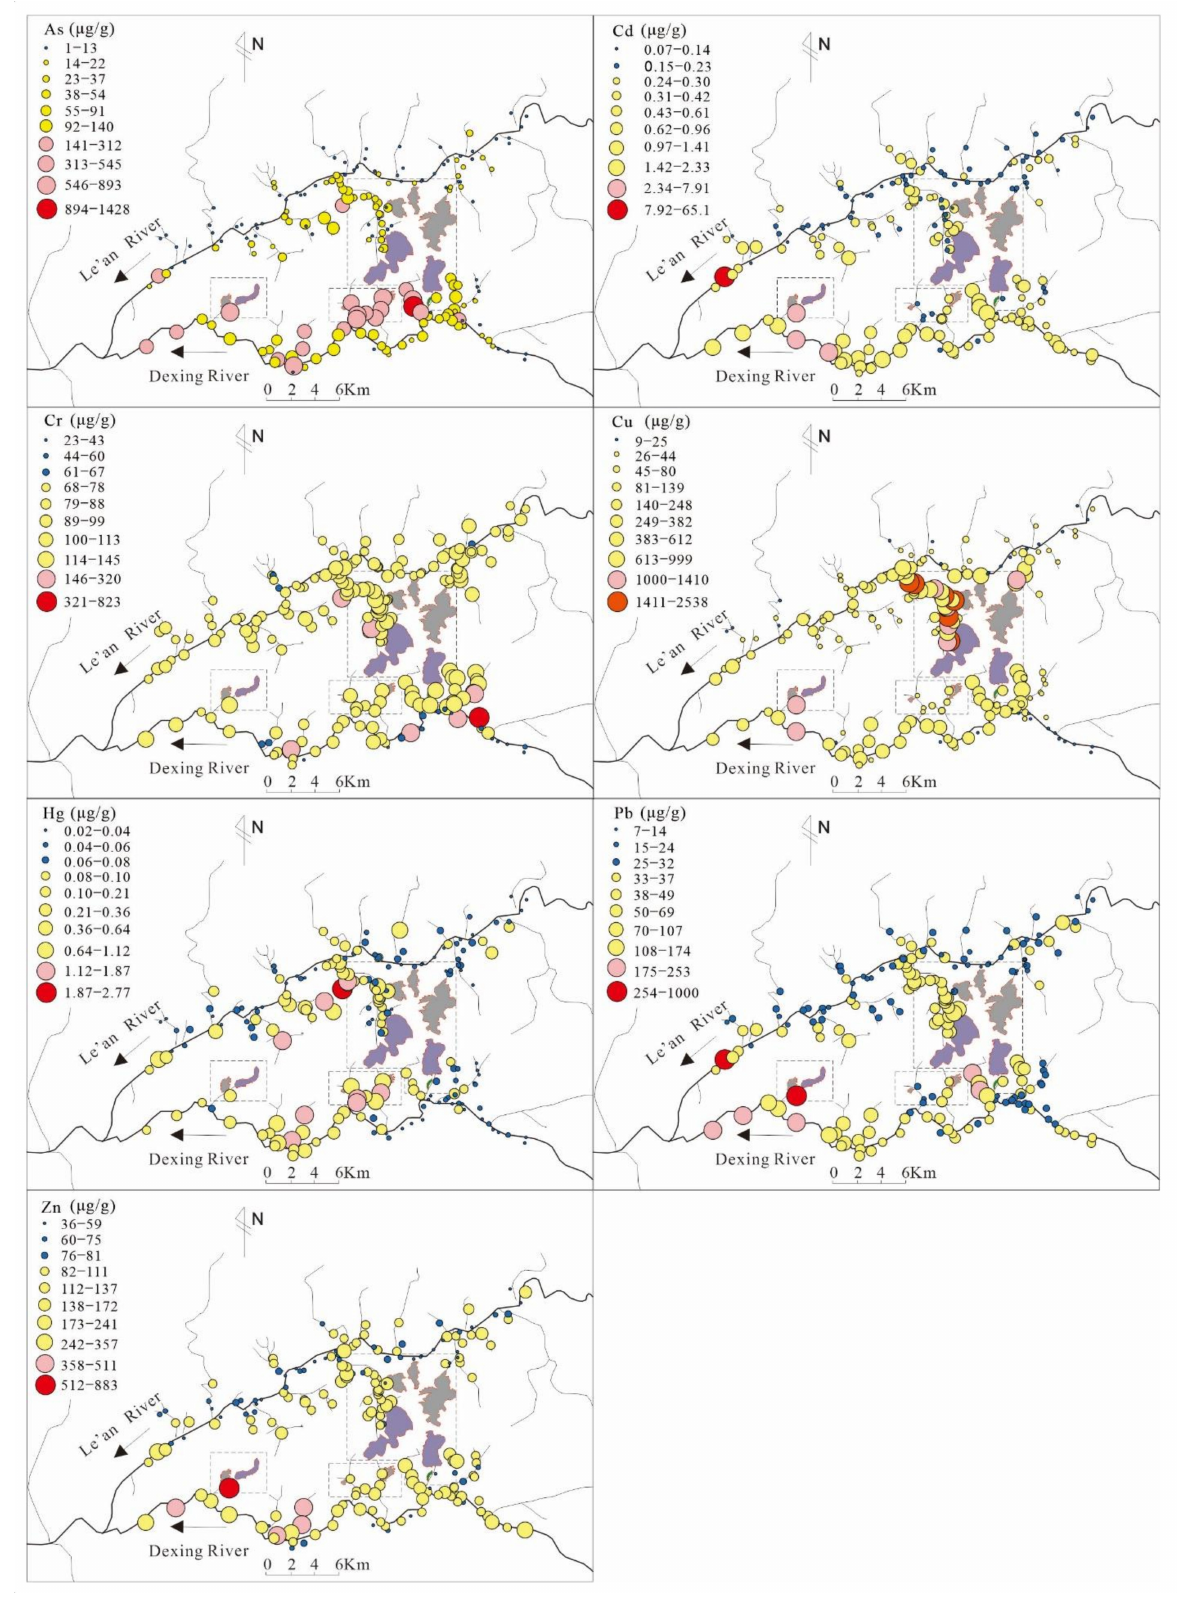
Figure 5. HMs distribution in sediments